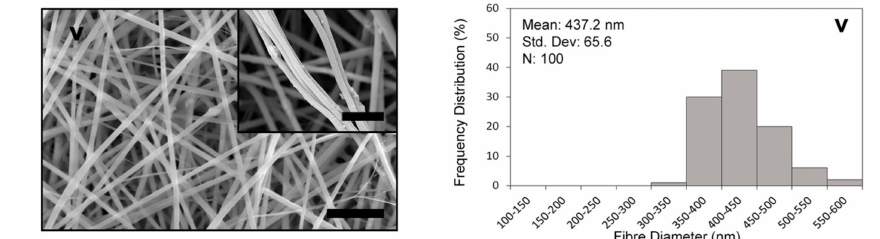
Figure 1. Morphology and diameters of electrospun fibres. ( A ) SEM images of SF/HNT composite